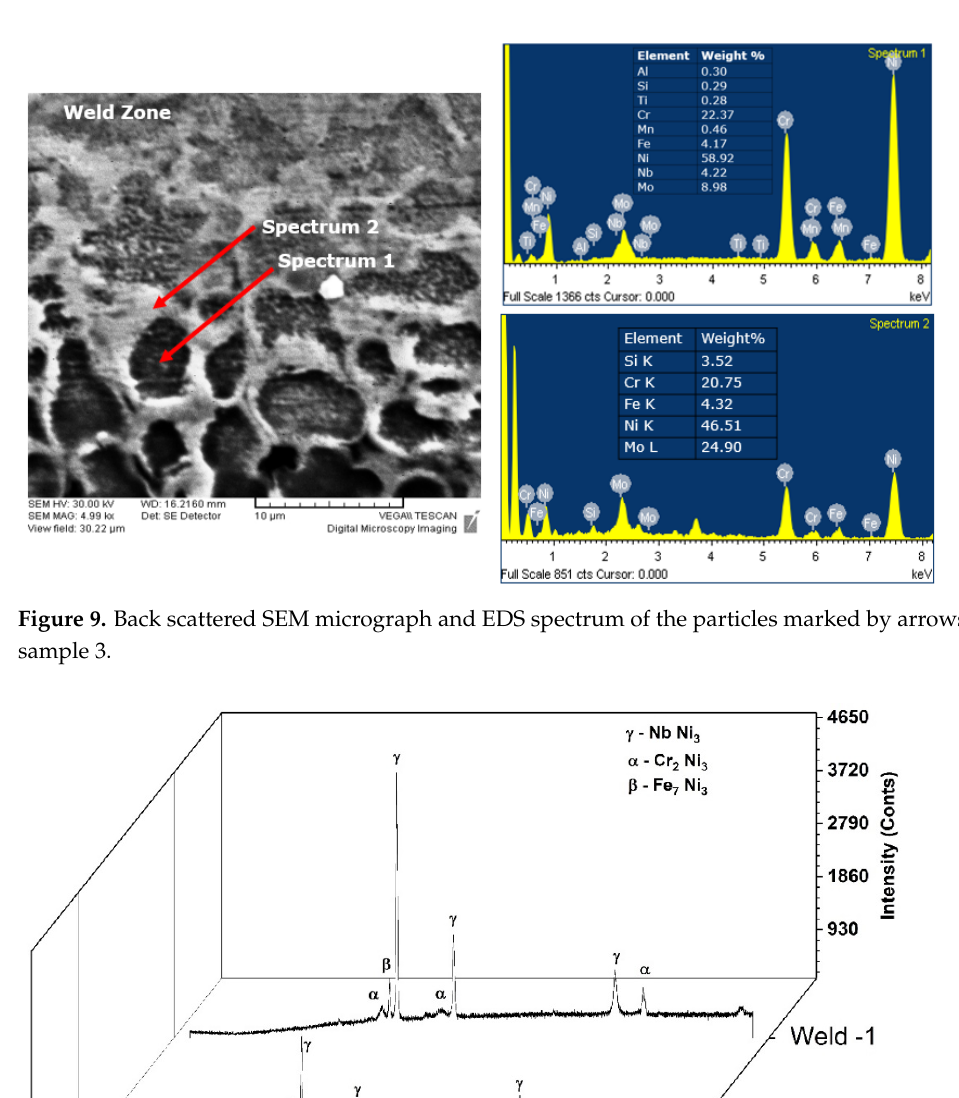
Figure 8. ( a ) Macrograph of Inconel 625 laser beam welded joint (weld 3) showing a defect-free weld